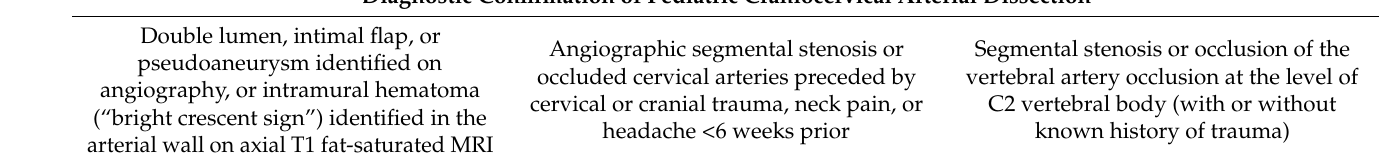
Table 3. Imaging characteristics of confirmed diagnosis of arterial dissection in pediatrics. Dissection can present in a multitude of ways, and the presence of any one of these findings on angiography represents the occurrence of a